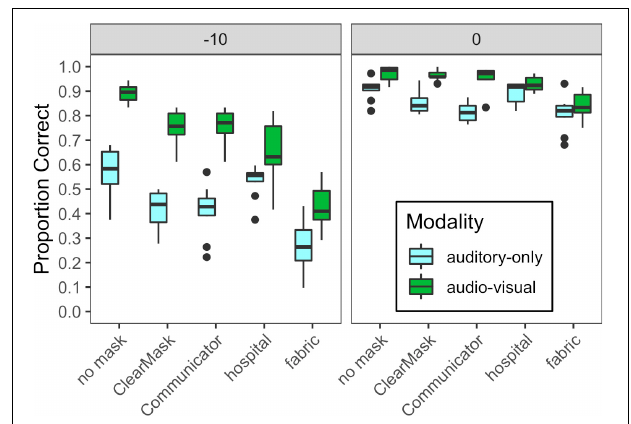
FIGURE 5 | Distribution of scores for each of the auditory-only and audiovisual stimulus conditions, plotted separately for each of the two SNRs tested in Experiment 2, as indicated at the top of each panel. Mask type is indicated on the horizontal axis, and cue condition is indicated with box fill, as defined in the legend. Vertical lines indicate the median, boxes span the 25th to 75th percentiles, and vertical lines span the 10th to 90th percentiles.